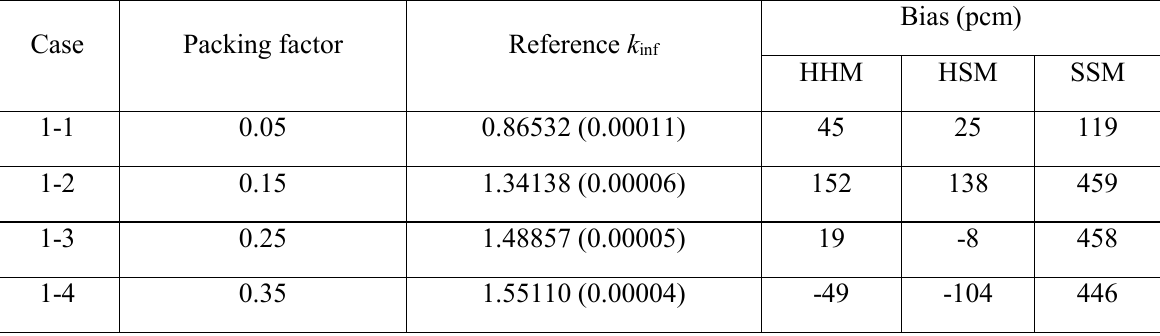
for different packing inf